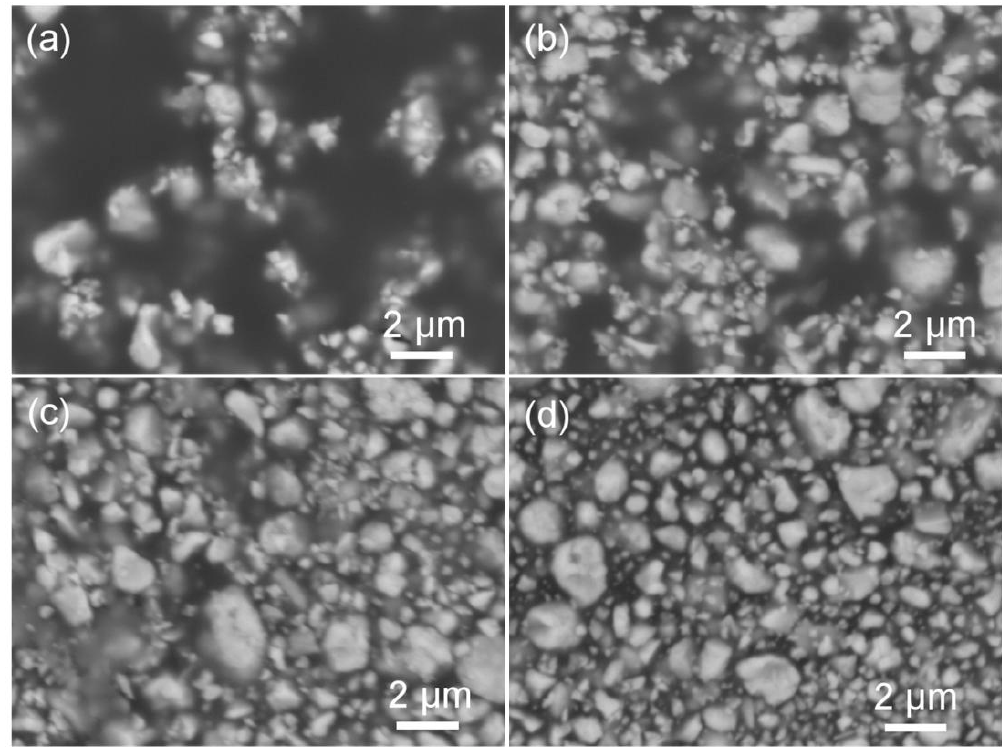
Figure 3. Typical SEM images of the BPA films fabricated via Route 1 with various BT/polymer mass ratios ( M BT / M polymer ): ( a ) 2, ( b ) 3, ( c ) 4 and ( d ) 5.